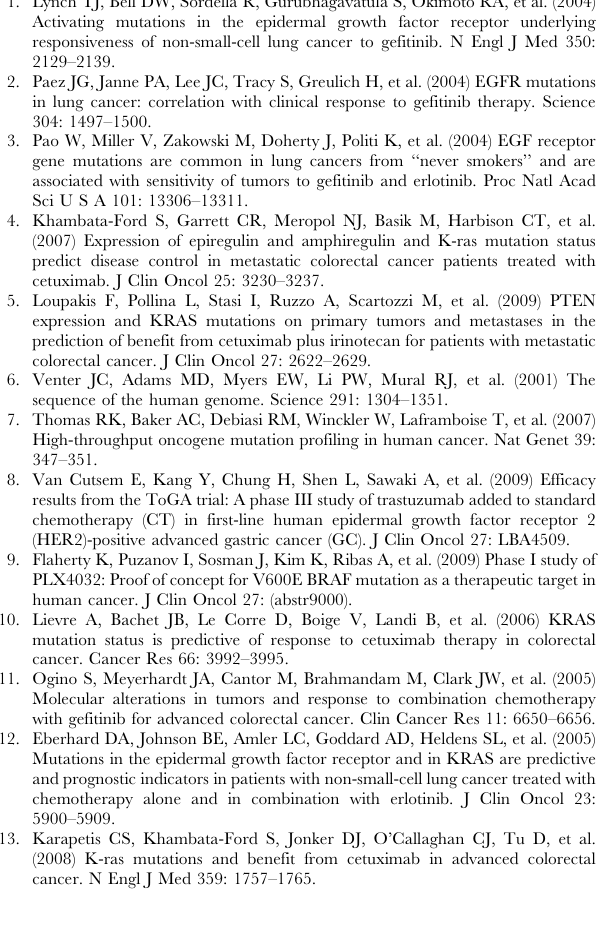
Table S1 OncoMap 3 core PCR primer and extension probe sequences.